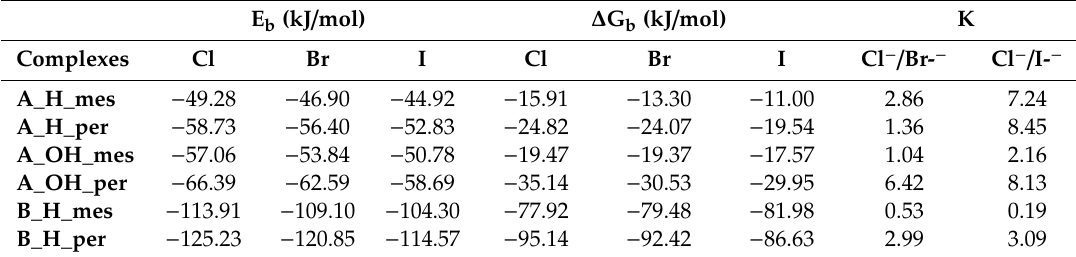
Table 3. Binding energies (E b ) and binding free energy ( ∆ G b, at 298K) (kJ / mol) upon complexation at m062x / aug–cc–pVTZ computational level. Equilibrium constants for the halogen-bonding interaction. E b (kJ / mol) ∆ G b (kJ / mol) K Complexes